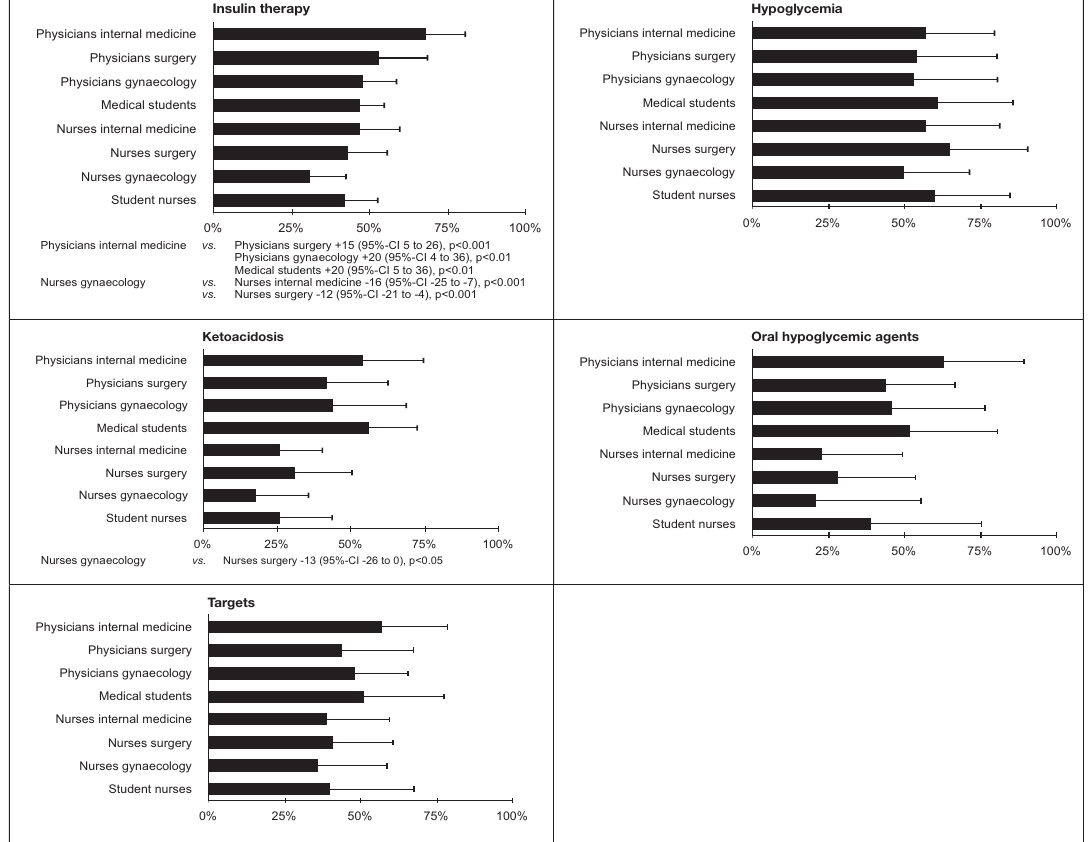
Scores of subscales of different study groups (mean ± SD) with relevant statistics (ANOVA withTukey-Kramer multiple comparisons test) in medical house staff and nursing house staff respectively.